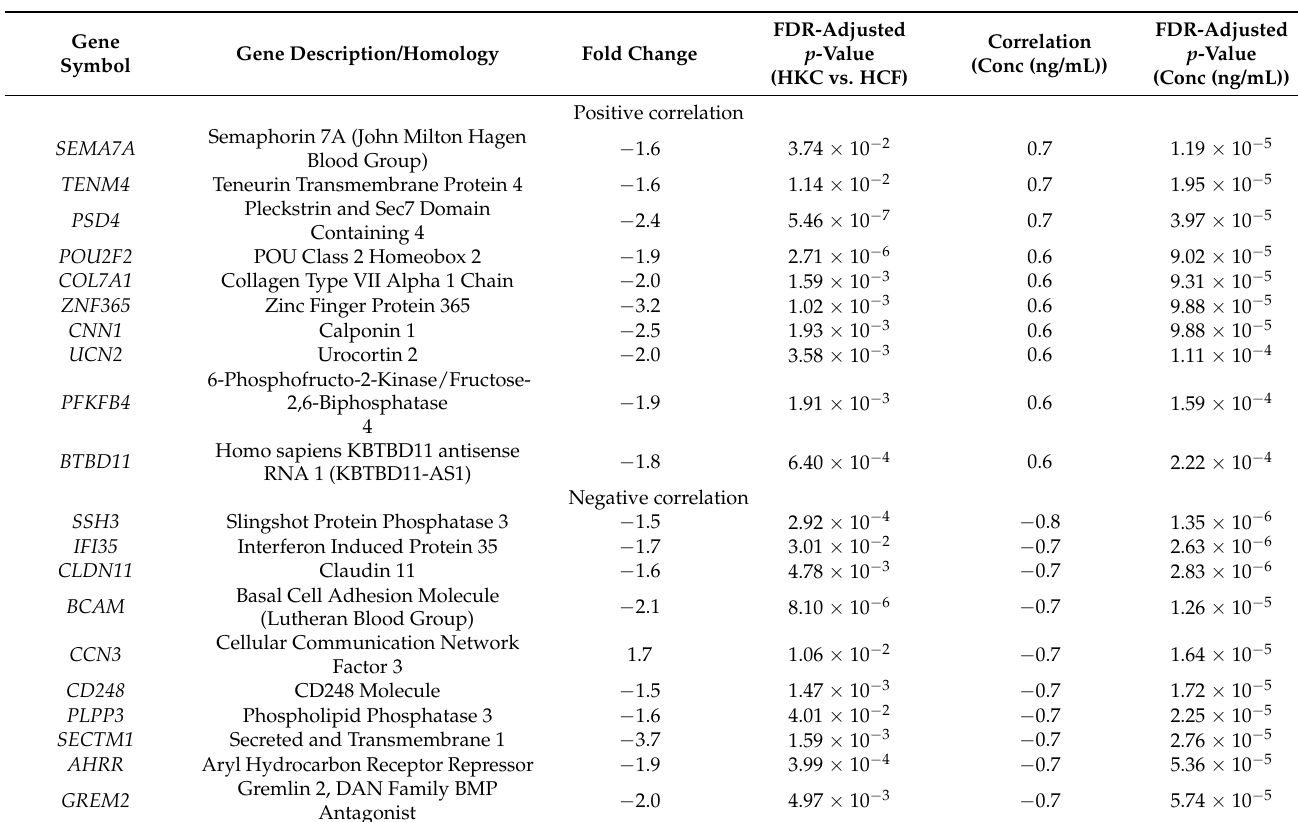
Table 3. KC-altered genes with a positive correlation (top 10 genes) and a negative correlation (top 10 genes) with TGF β 1